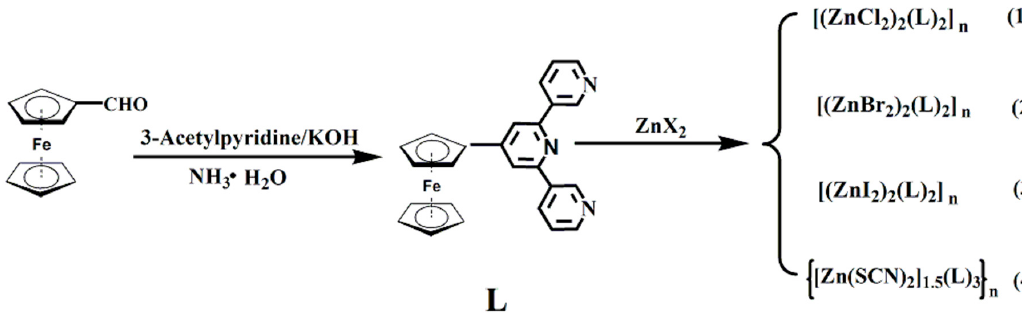
Figure 2. Synthetic routes for the ligand and complexes 1 – 4 .